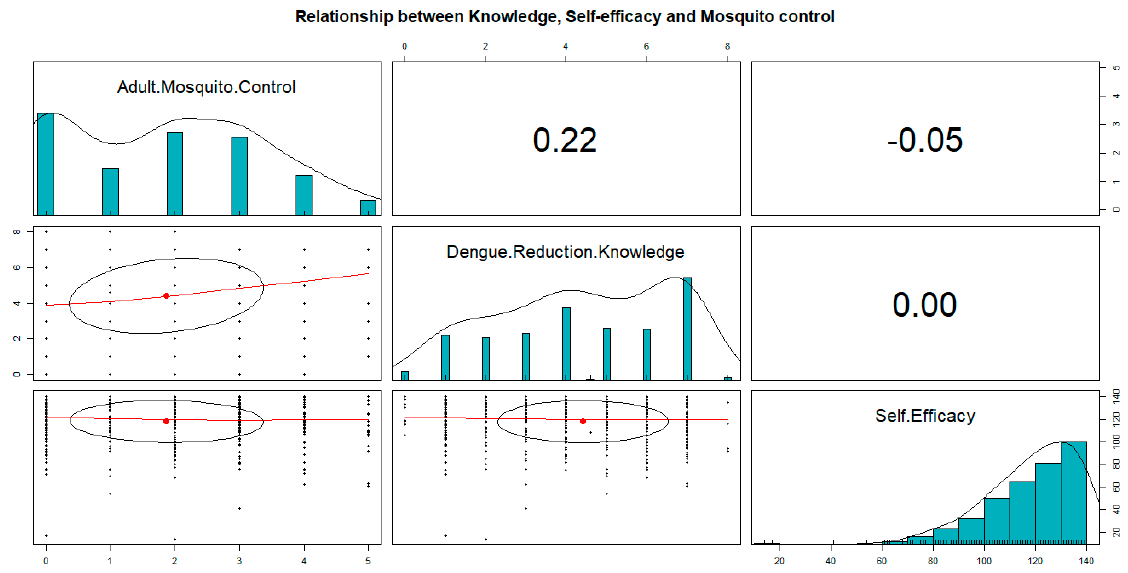
Figure 3. Pearson’s correlation of knowledge, self-efficacy, and mosquito control measure